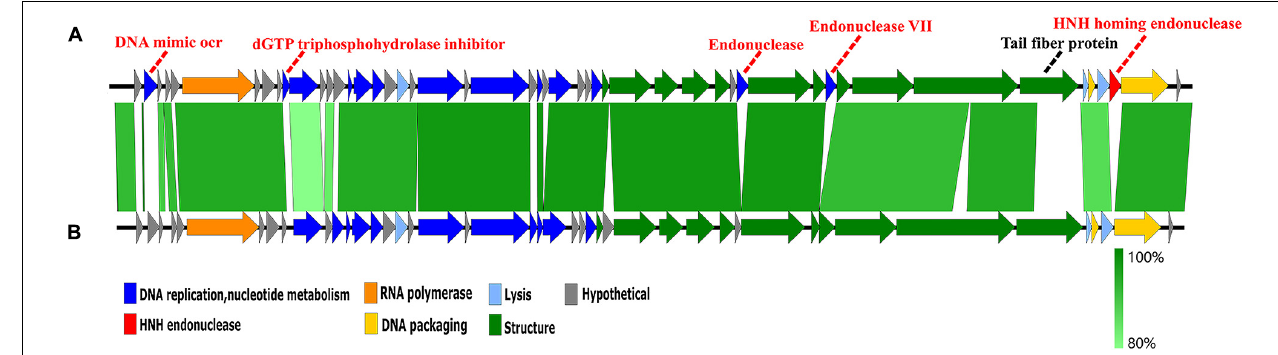
FIGURE 7 | Genome comparison of the Hafnia phage Ca (A) and Escherichia phage ST31 (B) . The color of each arrow refers to the functional groups. The orientation of the arrows indicates the direction of gene transcription. The homologous regions are represented by green bars, with their depth reflecting the degree of sequence similarity. Compared to the genome of Escherichia phage ST31, Hafnia phage Ca genome contains extra genes represented by red dotted lines. The black dotted line indicates a non-conserved